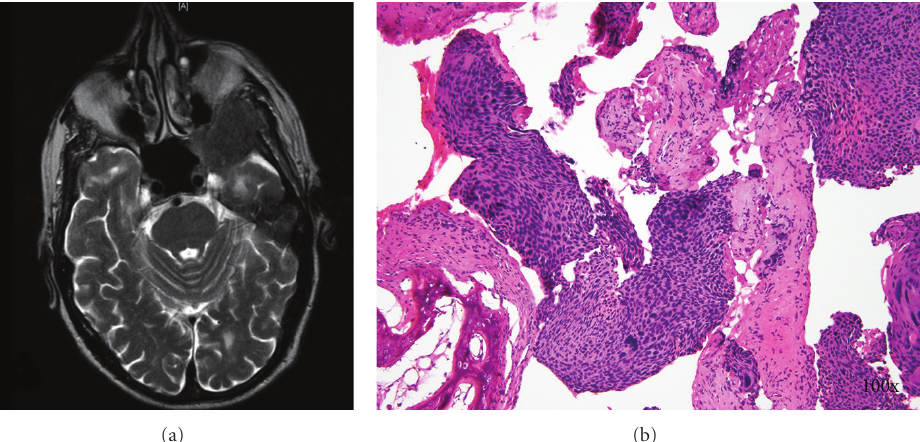
Figure 3: MRI demonstrating left frontal intracranial lesion (a) and histology from the biopsy of this lesion showing metastatic squamous cell carcinoma